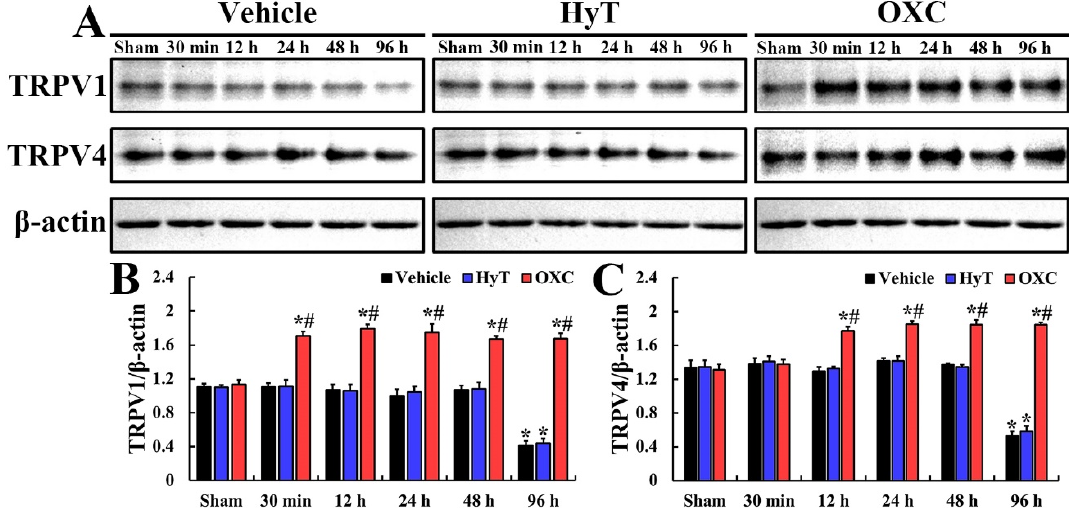
Figure 4. ( A ) Representative immunoblots of TRPV 1 in all groups at 30 min, 12, 24, 48, and 96 h after tFI or sham operation. In the tFI+vehicle and tFI+HyT groups, both TRPV1 and TRPV4 levels were not significantly altered until 48 h after tFI, but they were significantly lowered at 96 h after tFI as compared with the corresponding sham+vehicle group. In the tFI+OXC group, TRPV1 and TRPV4 levels were significantly enhanced at 30 min and 12 h, respectively, after tFI, and the increased levels were maintained until 96 h after tFI. ( B , C ) Protein levels normalized to β -actin of TRPV1 ( B ) and TRPV4 ( C ). The bars indicate the means ± SEM ( n = 5 for each group; * p < 0.05 vs. sham+vehicle group, # p < 0.05 vs. corresponding time of the tFI+vehicle